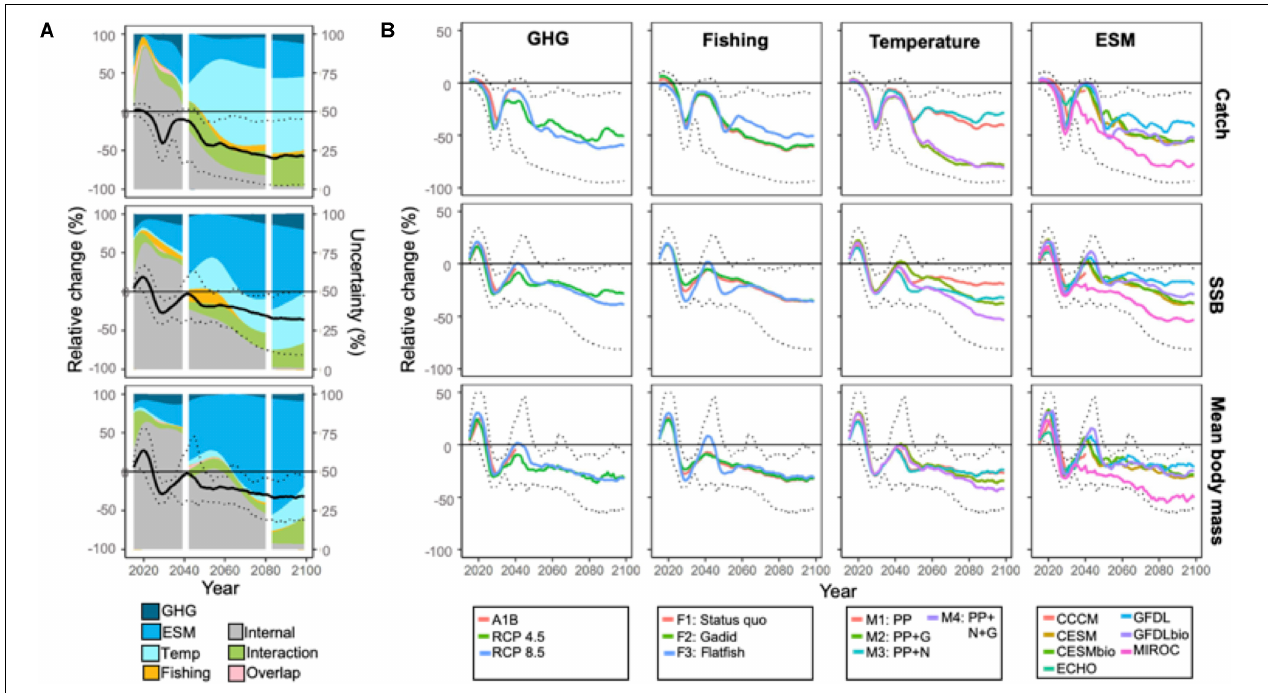
FIGURE 2 | (A) Projections of total catches of EBS predator species, spawning stock biomass (SSB), and community mean body mass relative to 2014 levels. Black solid line corresponds to ensemble mean. Dotted lines indicate the minimum and maximum projections from the ensemble. Projection trends are overlaid on area plots that indicate the proportion of total variance in ensemble projections explained by scenario [greenhouse gas emissions (GHG) and fishing] and structural [Earth system model (ESM) and temperature effect] uncertainty and internal variability. The proportions explained by interactions between factors, and variance mutually explained by multiple factors (overlap) are also indicated. The vertical white lines demarcate time periods that differ with respect to the number of ESM members. For (B) , solid colored lines correspond to projection averages within levels of the uncertainty source. For reference, maximum and minimum ensemble projections are noted (dotted